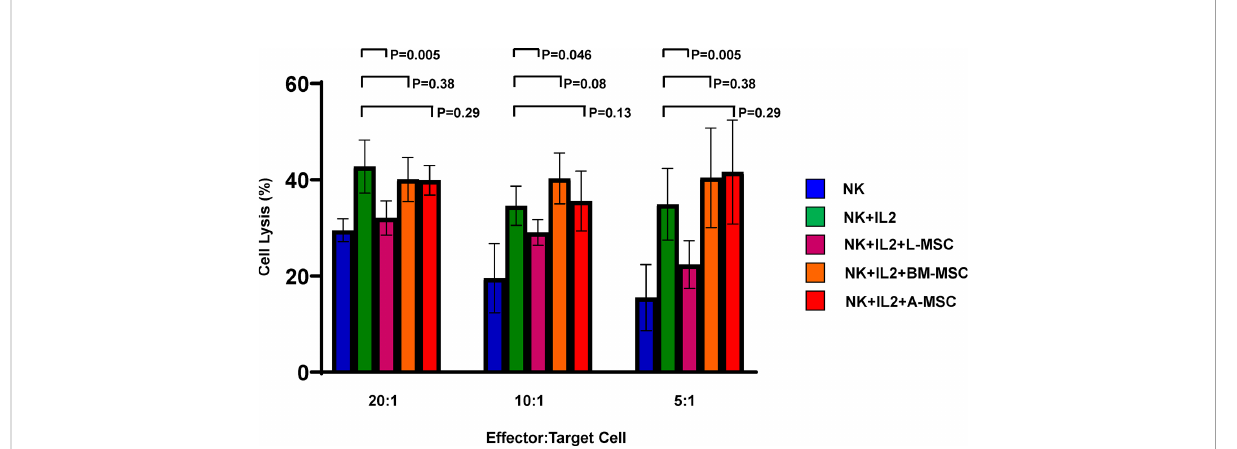
FIGURE 6 MSCs ’ impact on NK cell cytolytic activity. NK cells cultured alone with or without IL-2 or in direct contact with MSCs from different sources for 72 h at 10:1 NK : MSC ratio. NK cells were harvested and used as effector cells in a Cr51 release assay against K562 target cells at different effector/target cell ratios. Data is presented as percent lysis of the target cells and is representative of 6 independent experiments. L-MSC, liver mesenchymal stromal cell; BM-MSC, bone marrow mesenchymal stromal cell; A-MSC, adipose mesenchymal stromal cell; NK, natural